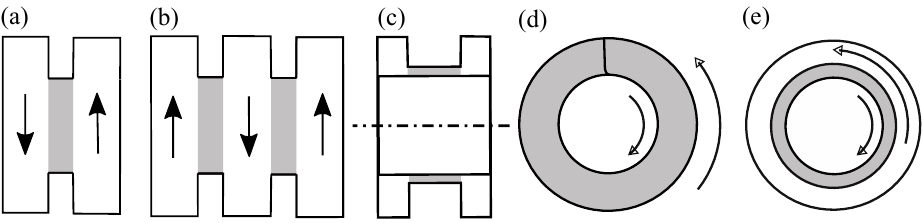
Figure 1 : Shear test specimens for the characterisation of plastic behavior of sheet materials: (a) Single sided shear test [3], (b) Miyauchi shear test [4], (c) Tubular specimen (d) Marciniak round sheet specimen [5], and (e) In-plane torsion test [1]. The grey colour in the figure represents the gauge section of the